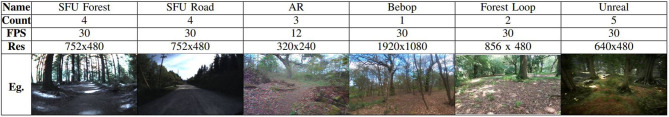
Table showing datasets used in this work, with video count, frame rate, resolution and an example frame.